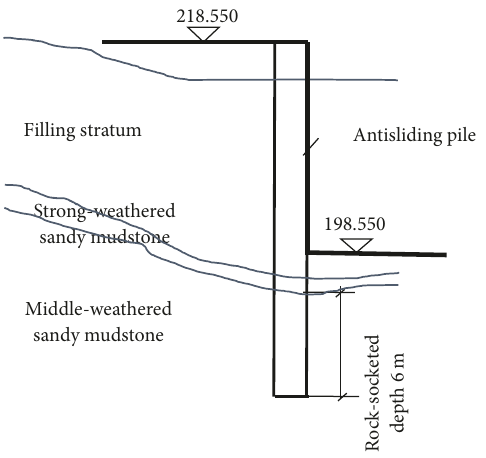
Figure 7: The diagram of retaining wall.